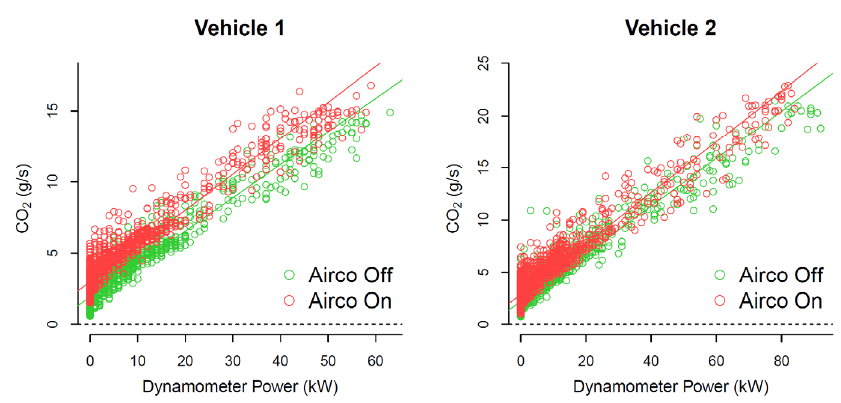
Figure 6. Measured CO 2 and dynamometer power with air conditioning on and off.